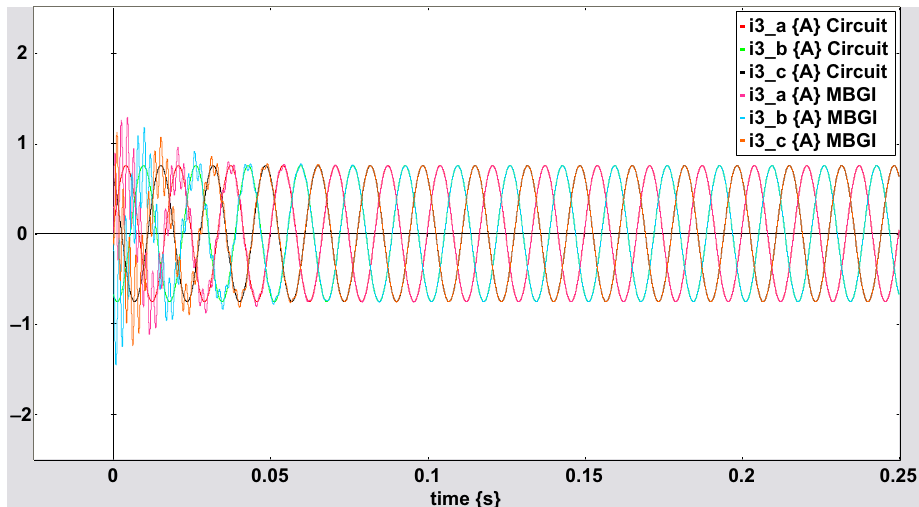
Figure A6. Three-phase currents for i 3 : ( a ) single-phase equivalent circuit; ( b ) MBGI. Figure A7 shows the simulation of the equivalent reduced circuit of Figure A1 and the MBGI of Figure 10 for i 3 simultaneously.